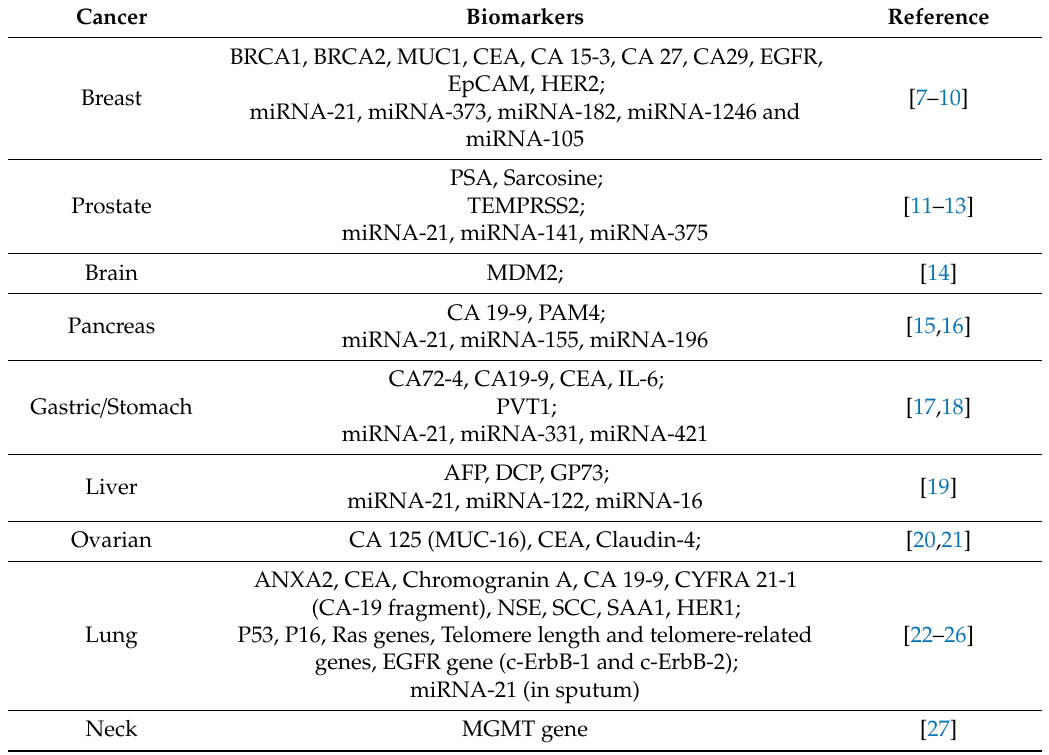
Table 1. Biomarkers associated with the diagnosis and prognosis of